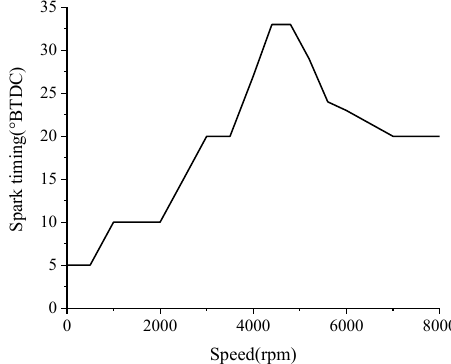
Figure 5. Relationship between spark timing and speed.